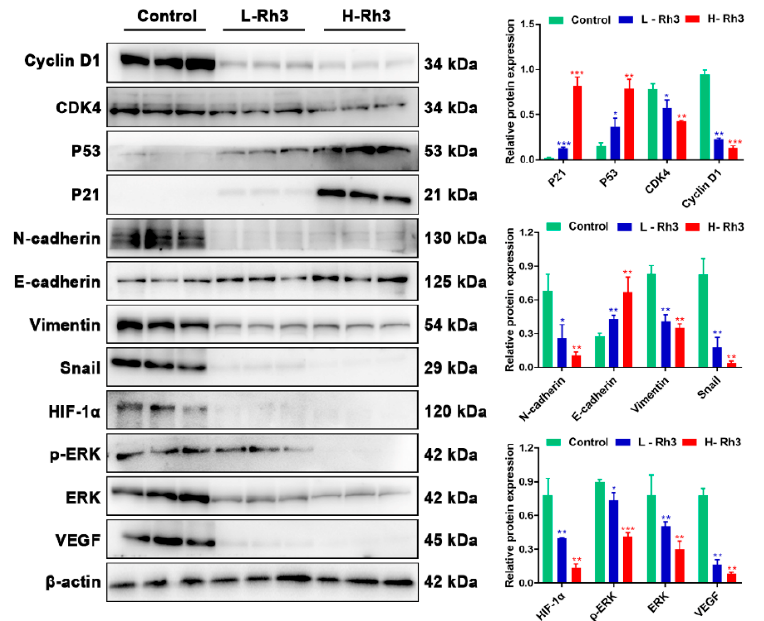
Figure 10. Rh3 significantly inhibited lung metastasis in a pulmonary metastasis mouse model. ( A ) Incidence of lung metastases from the same group of animals. The extent of lung metastases was quantified by staining with Bouin’s solution. ( B ) Immunofluorescence staining of HIF-1 α protein in lung tissues. ( C ) Immunofluorescence staining of E-cadherin and N-cadherin proteins in lung tissues. ( D ) Immunofluorescence staining of ERK and p-ERK proteins in lung tissues. L-Rh3, 50 mg/kg; H-Rh3, 100 mg/kg; Gefitinib, 40 mg/kg.